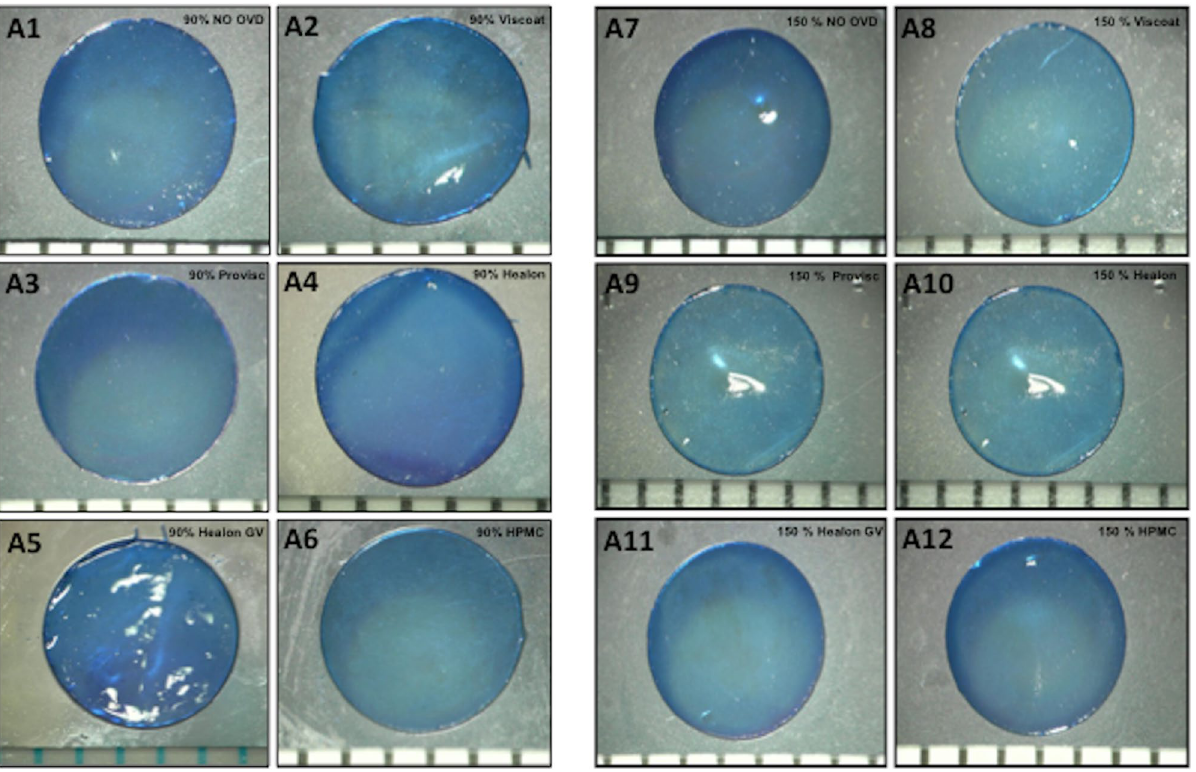
Figure 2. Explanted porcine lens-capsules. The figure shows explanted porcine capsules, which were stained with trypan blue (0.1%), and represent the mean circularity of different sub-groups, with ( A1 – A6 ) 90% energy and ( A7 – A12 ) 150% energy,